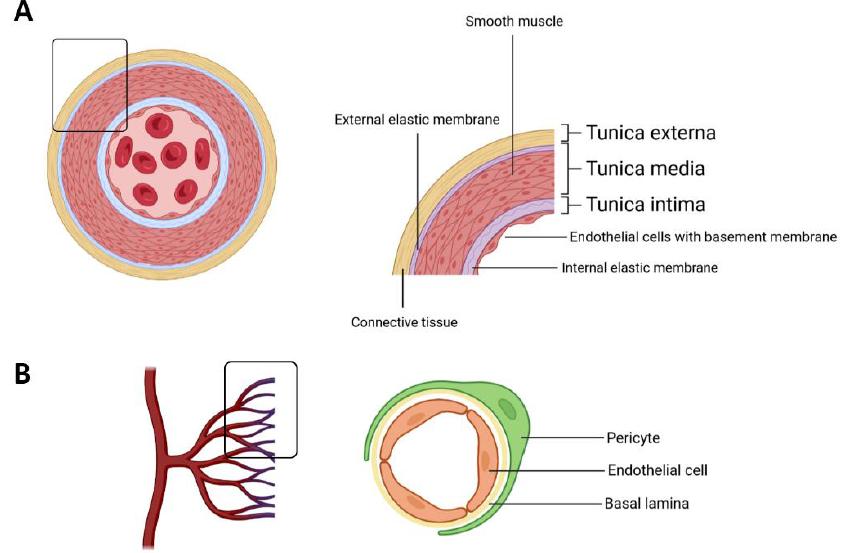
Figure 1. Schematic representation showing the main components of the blood vessel wall. ( A ) The transverse section of an artery; ( B ) cellular components of a blood capillary.